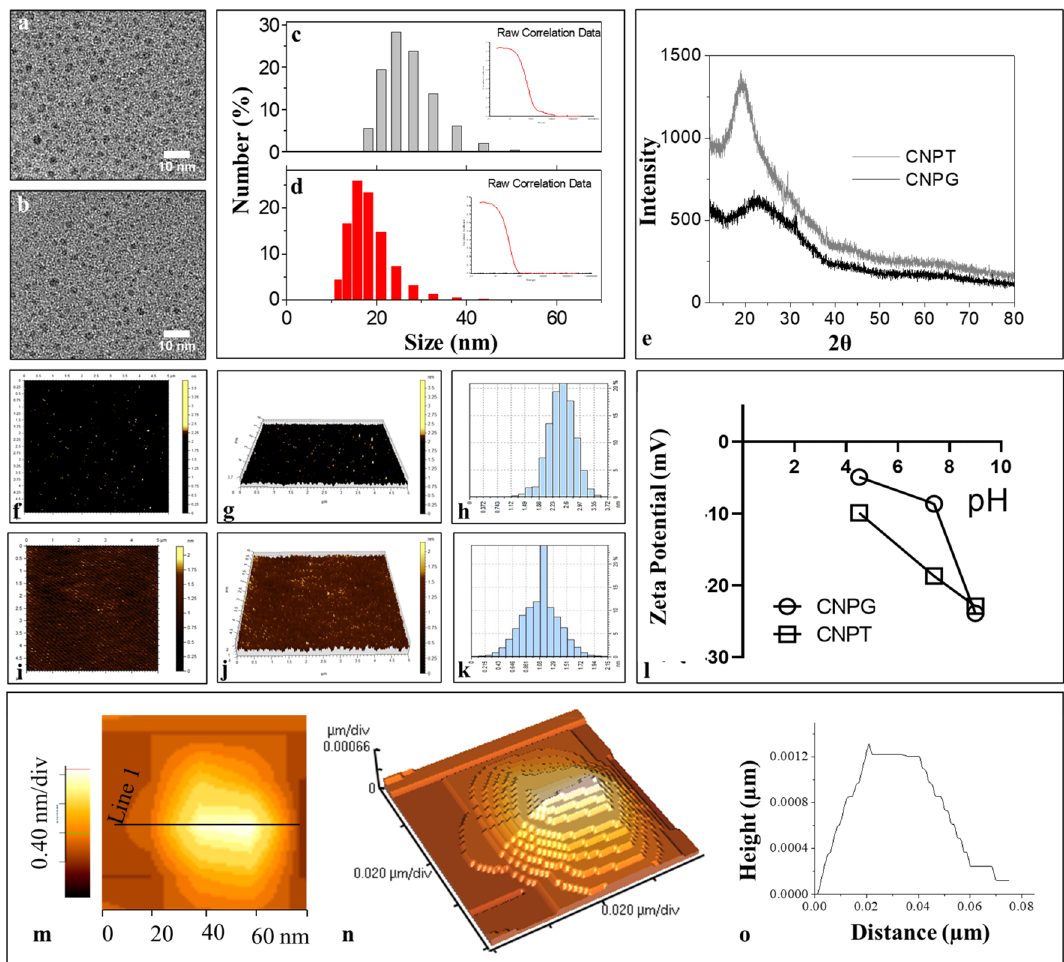
Figure 1. Structural characterization of the carbon-nanodots. ( a ) TEM image of CNP-trehalose (CNPT), ( b ) TEM image of CNP-glucose (CNPG), ( c ) DLS showing the hydrodynamic size of CNPT, ( d ) DLS showing the hydrodynamic size of CNPG, ( e ) XRD spectra of CNPT and CNPG showing broad peak centred at 2θ ~ 20°, ( f ) AFM topography of CNPT, ( g ) Three-dimensional view of CNPT, ( h ) Height profile of CNPT, ( i ) AFM topography of CNPG, ( j ) Three-dimensional view of CNPG, ( k ) Height profile of CNPG, ( l ) Zeta potential of CNPT and CNPG at different pH, ( m – o ) Magnified AFM topography of CNPG confirming the plate-like surface morphology of